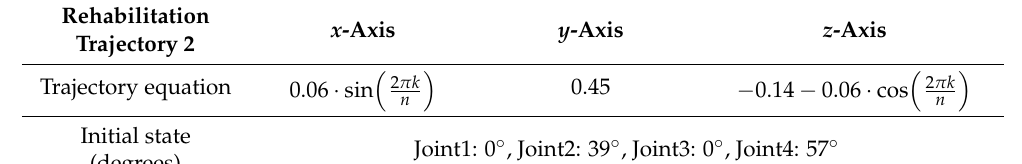
Figure 19. Motion trajectory 2 of each axis of the robot arm is planned by kinematics.